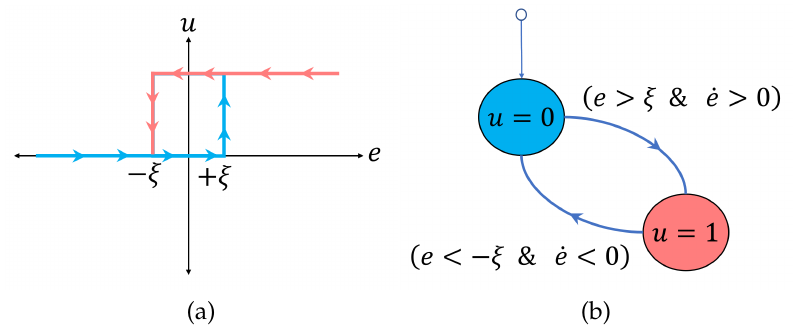
Figure 3. Hysteresis function: ( a ) hysteresis loop as a function of tracking error; ( b ) state machine to describe the control transition as a function of error dynamics, hysteresis amplitude parameter and control